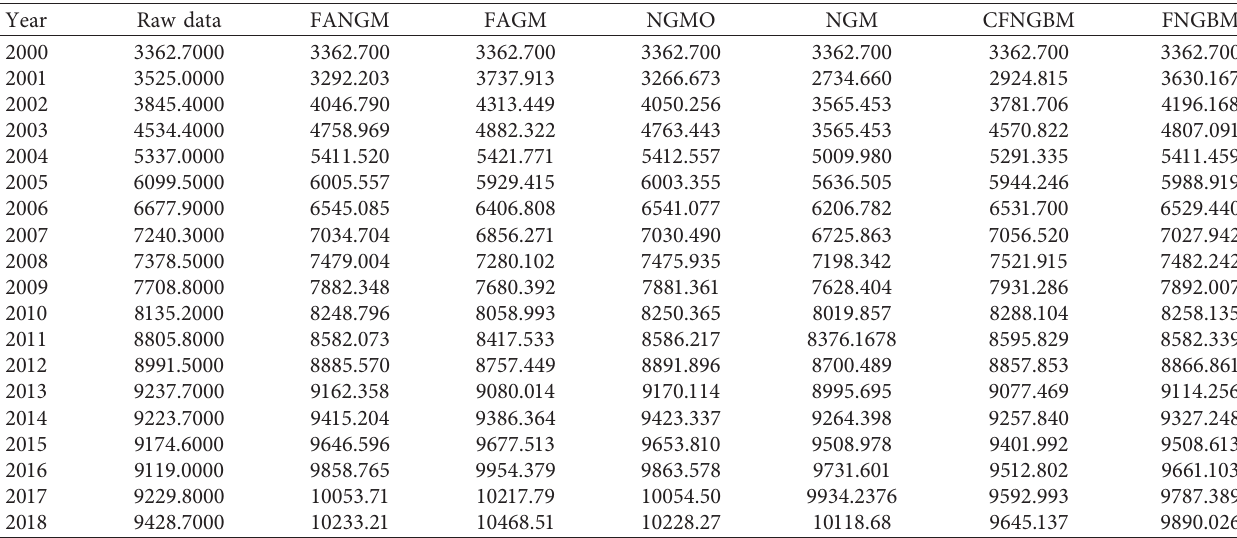
Table 4: Results of CO 2 emissions in China using six